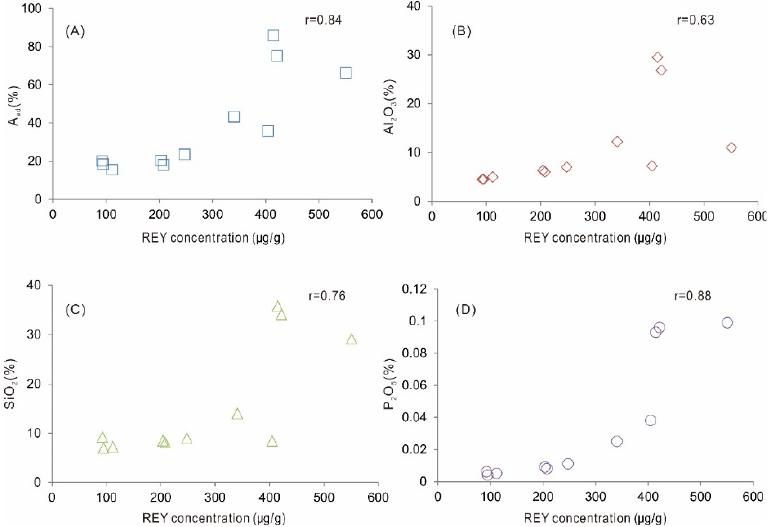
Figure 7. Relations between REY and ash yield (A ad ) ( A ); Al 2 O 3 ( B ), SiO 2 ( C ), and P 2 O 5 ( D ) of coal seam in the Donggou mine.